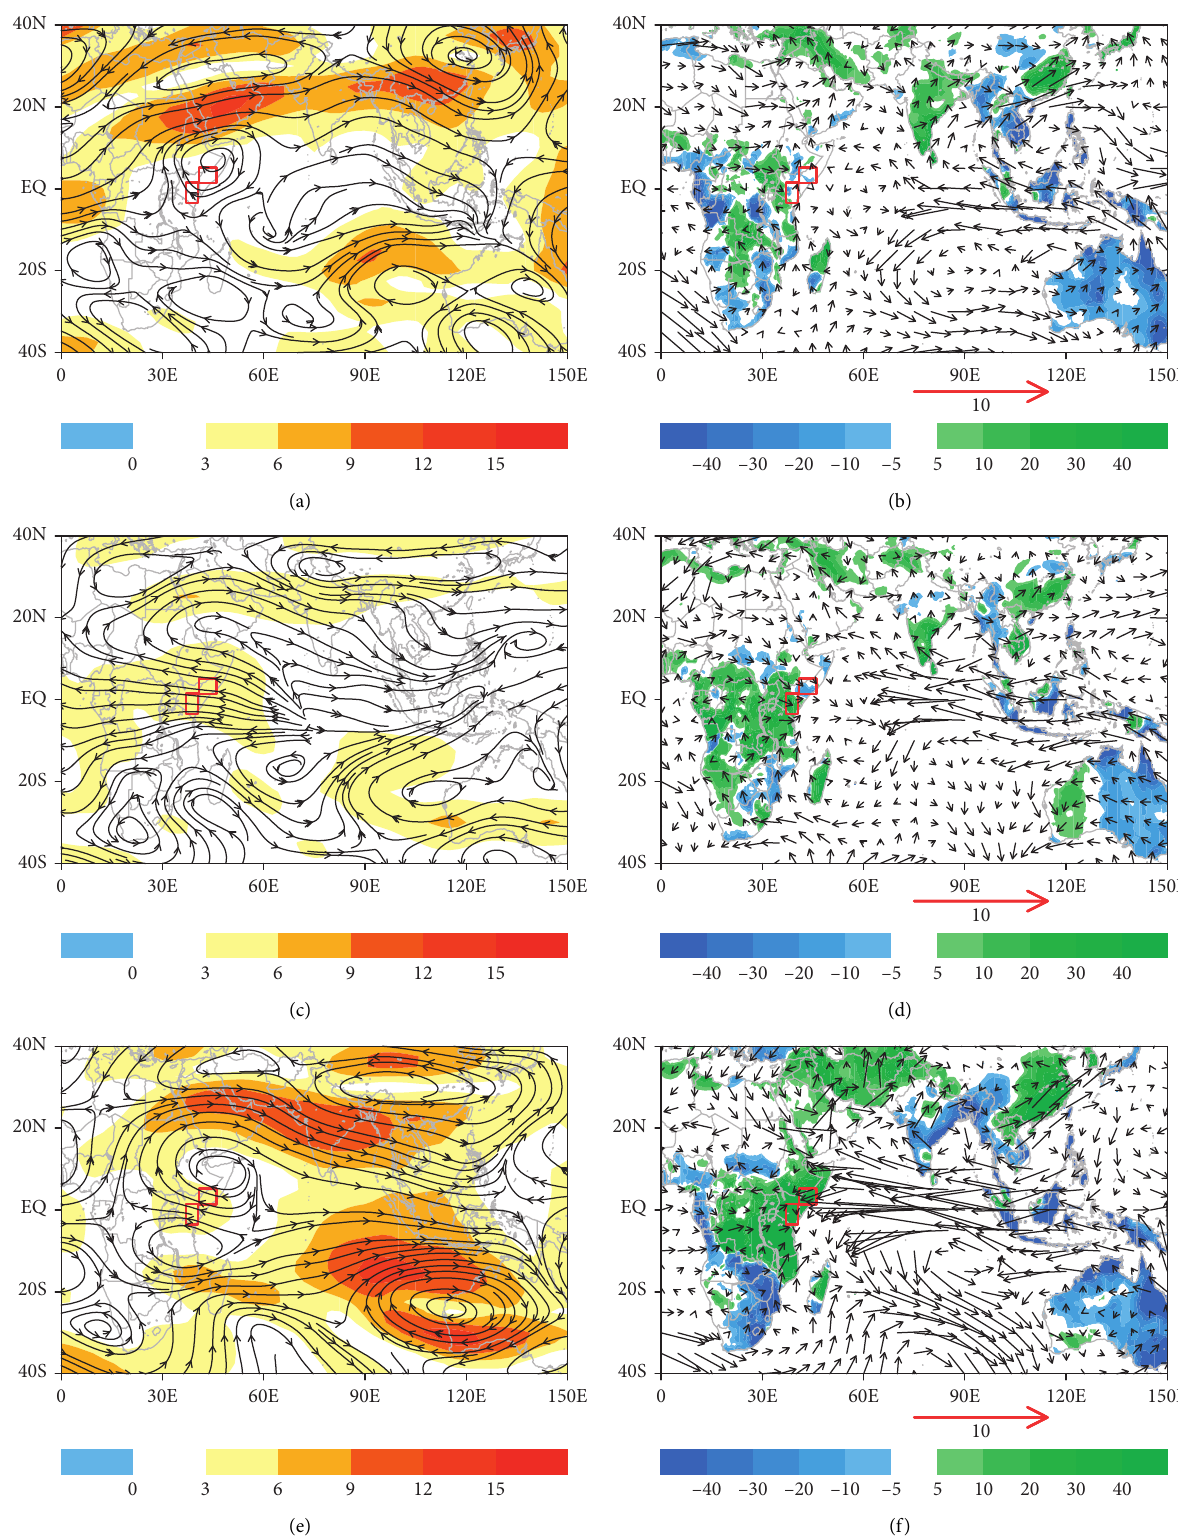
Figure 13: The difference of 200-hPa wind (streamline; left column), 850-hPa wind (vector in m s − 1 ), and rainfall (shaded in mmmonth − 1 ) (right column) in OND between El Nin ̃ o alone and La Nin ̃ a alone years (a, d), between pIOD alone years and nIOD alone years (b, e), and between El Nin ̃ o and pIOD coexisting and La Nin ̃ a and nIOD coexisting years(c, f). The magnitudes of wind are shaded in (a, b, and c). The red boxes marked in each panel represent the OND